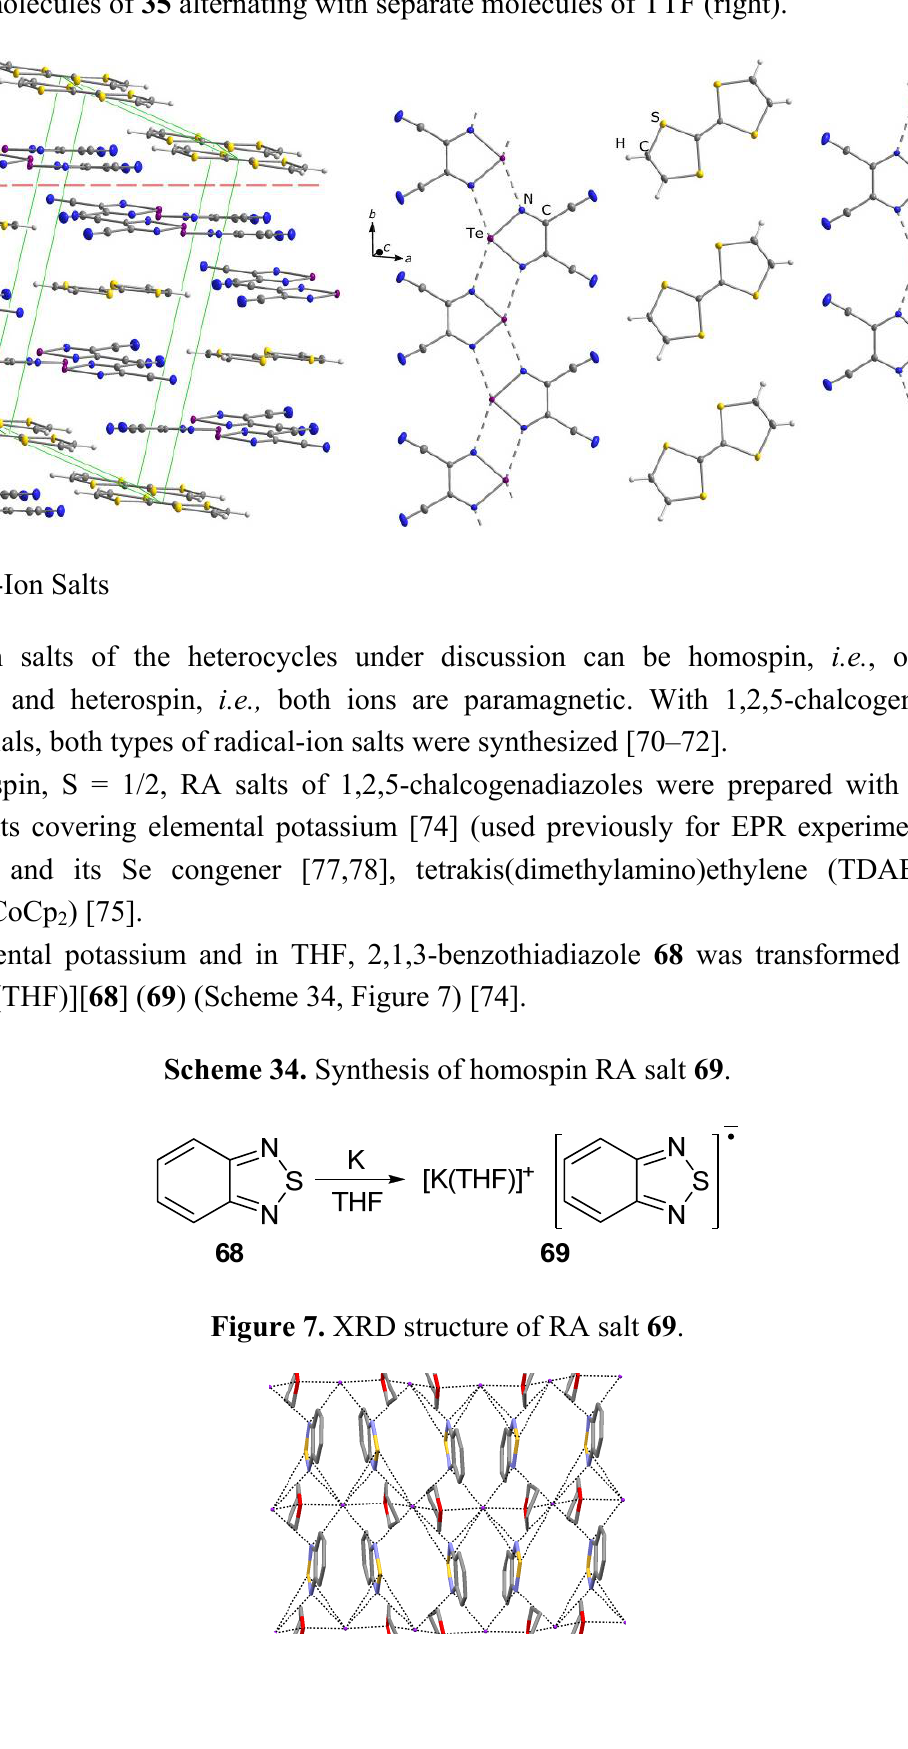
Figure 6. XRD structure of CT complex TTF ·35 . Layers containing flat D and A 2 molecules are extended in the directions marked by the dashed line (left). Each layer contains chains propagated along the b axis. The chains are composed of coordinatively bound molecules of 35 alternating with separate molecules of TTF (right).